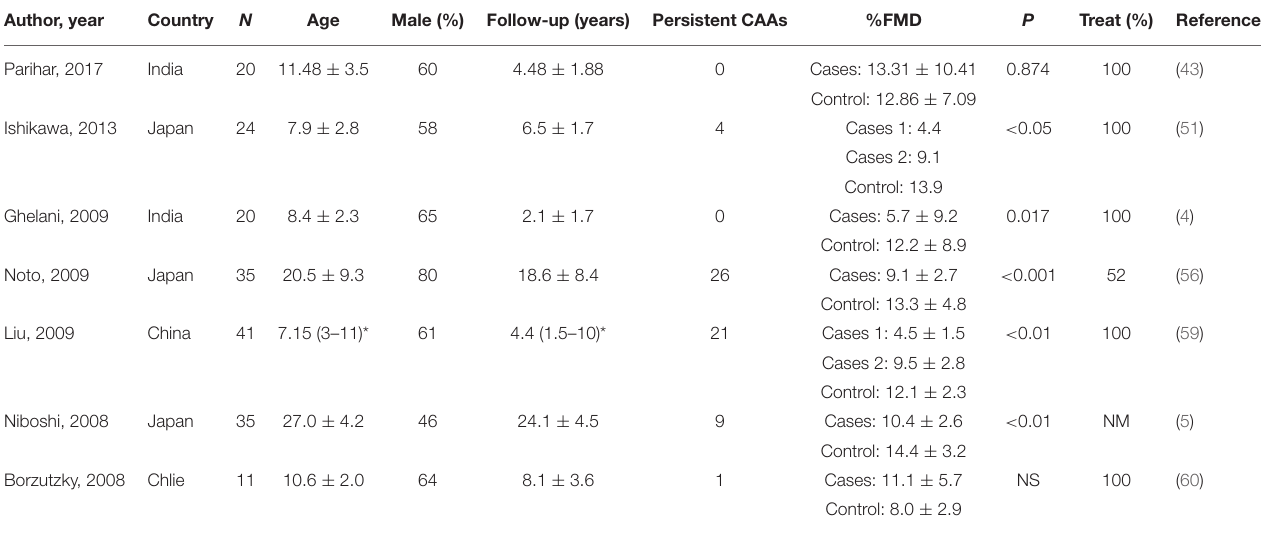
TABLE 2 | Studies on flow-mediated dilatation (FMD) in patients with a history of KD. Author,